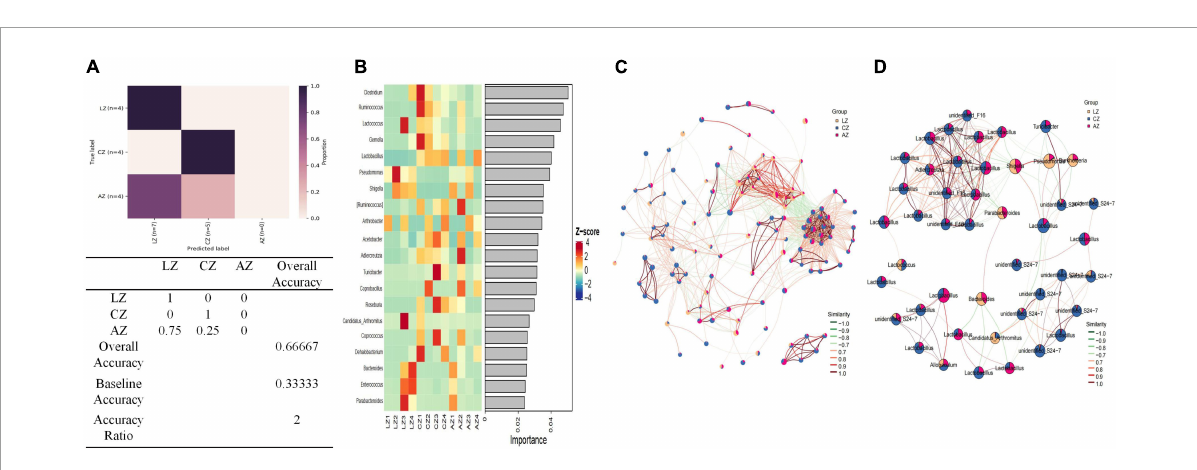
FIGURE9 Random Forests and network analysis. (A) Model accuracy, (B) ASV taxa heatmap, (C) network analysis, and (D) subnetwork analysis of dominant